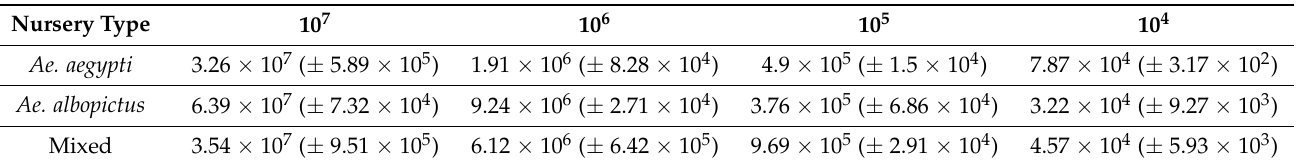
Table 1. Final bacterial concentration ( ± Standard Deviation) in CFU/mL of the Bacterial mixture (III(3)7 + 2362) tested against each Aedes species nursery type. Nursery